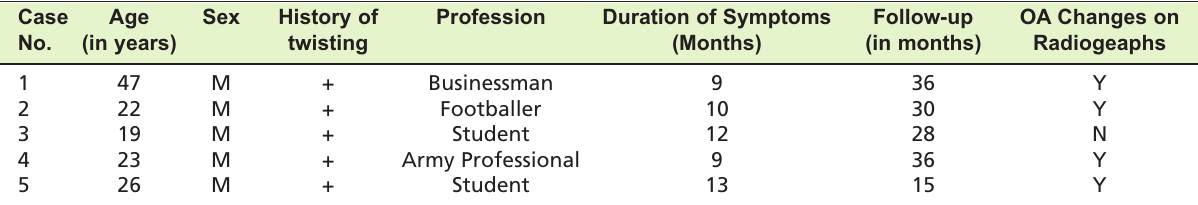
Showing Demographic details of the patients. (+: Present; Y: Yes; N: No; M: Male) Table I: